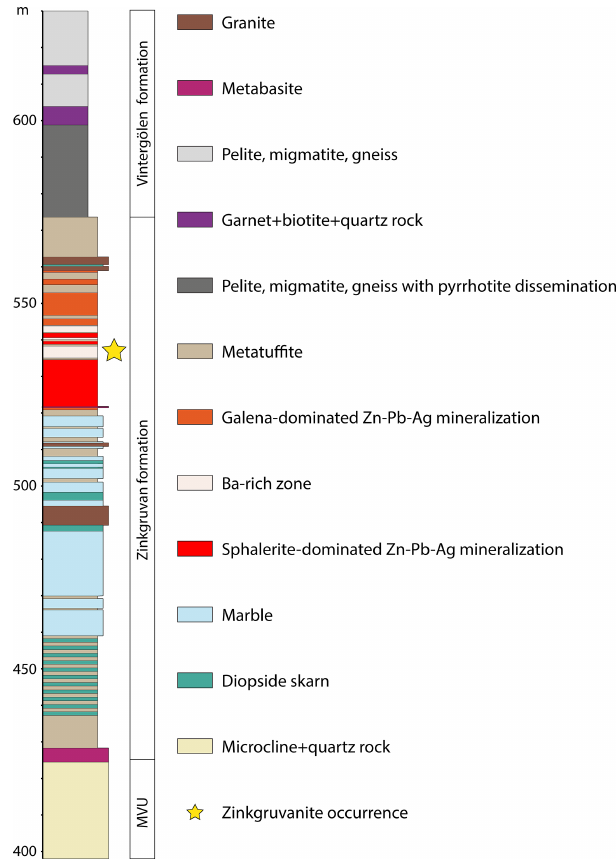
Figure 1. Drill core log section from the Zinkgruvan mine showing the position of the discovery location for the zinkgruvanite-bearing assemblage (yellow star). MVU: metavolcanic unit.